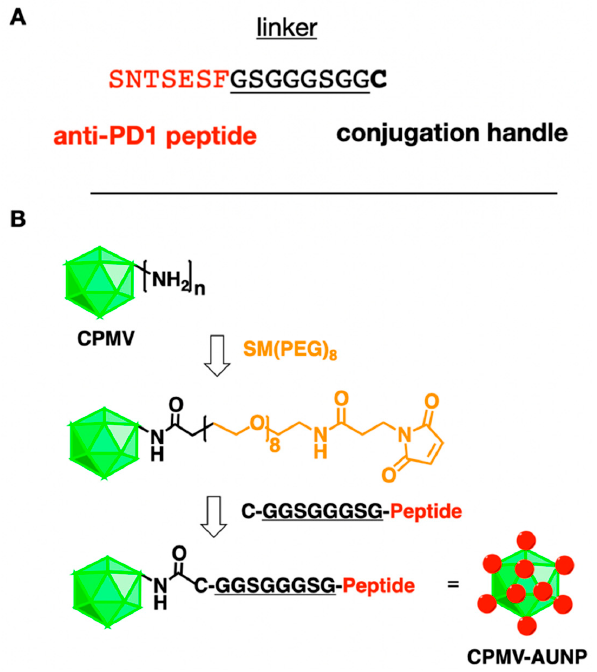
Figure 1. Conjugation scheme. ( A ) Amino acid sequence of the anti-PD-1 peptide SNTSESF and its linker and carboxy-terminal cysteine reside. ( B ) Bioconjugation scheme showing CPMV and its solvent-exposed amine groups from lysine side chains, followed by conjugation of the SM-(PEG) 8 linker, introducing a maleimide group that then reacts with the cysteine side chain of the peptide SNTSESFGSGGGSGGC (the terminal C is shown in bold in the structure). First, CPMV vs. CPMV-SMPEG vs. CPMV-AUNP formulations were analyzed by native agarose gel electrophoresis (Figure 2A), and after electrophoretic separation, gels were stained with GelRed and imaged under UV light to detect the encapsidated nucleic acids and then stained with Coomassie Brilliant Blue and imaged under white light to detect the protein capsids. Native agarose gel electrophoresis indicated that all samples analyzed remained intact: the RNA and protein bands co-localized and there was no evi- dence of broken particles, free RNA or aggregation. The CPMV-SMPEG formulation had higher electrophoretic mobility toward the anode, which was in agreement with positive charge reduction as a neutral linker (SM-PEG 8 ) conjugated to surface lysines. Mobility of CPMV-AUNP conjugates was reduced compared to the CPMV-SMPEG formulation, which could be explained by an interplay of charge and increased molecular weight.